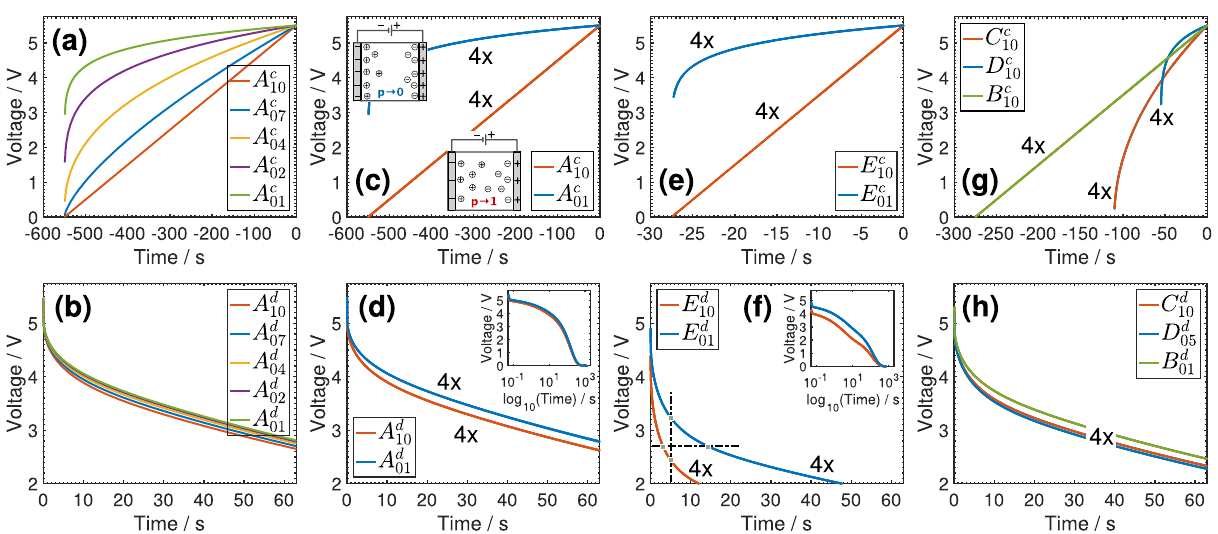
Figure 2. Charging sequence (first row) using a power supply with a voltage v c ( t ) = V cc ( t / t ss ) p , and discharging sequence (second row) into a constant 100 (cid:31) resistor of an NEC/TOKIN supercapacitor. ( a ),( b ) depict the charge/discharge voltage patterns for different values of p (1.0, 0.7, 0.4, 0.2 and 0.1) and t ss = 550 s (Table 1), i.e. A c 10 / A d 10 - A c 07 / A d 07 - A c 04 / A d 04 - A c 02 / A d 02 - A c 01 / A d 01 . ( c ),( d ) and ( e ),( f ) show the repeatability of the process for four consecutive cycles (4x, superimposed on top of each other) of charge/discharge with p = 1.0 and p = 0.1 ; in ( c ),( d ) waveforms A c / E d 01 - E c 10 / E d 01 . In ( g ),( h ), we applied the sequence of charge/discharge codes [ B c 10 / B d 10 - C c 05 / C d 05 - D c 01 / D d 01 ]–[ B c